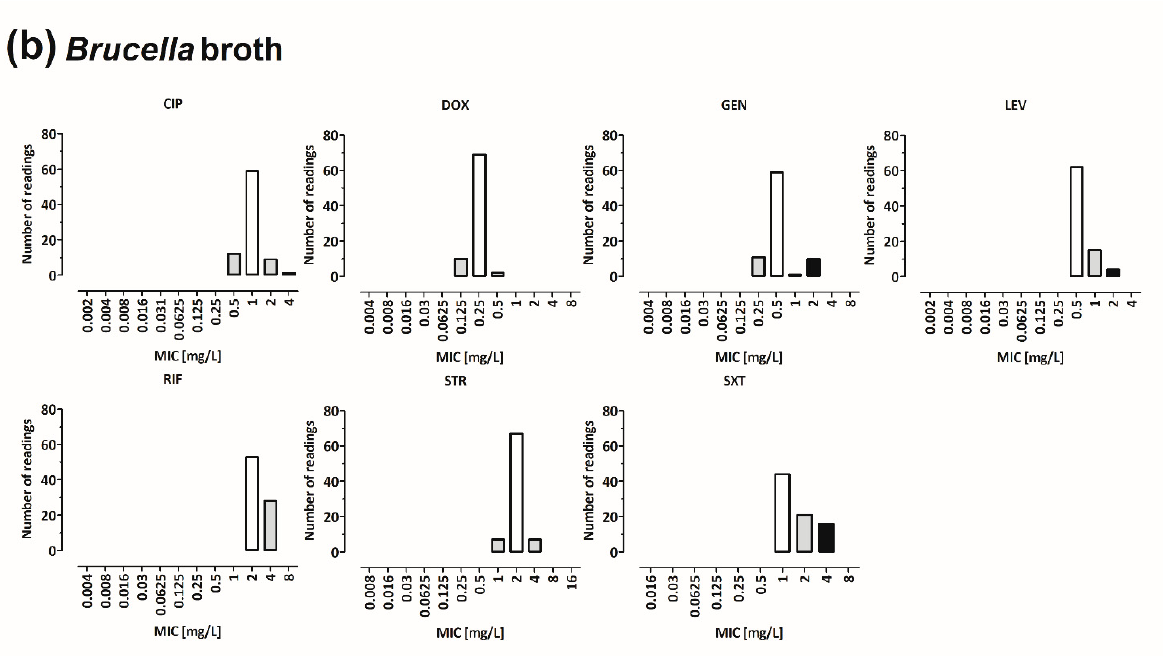
Figure 6. MIC values resulting from the interlaboratory validation (ILV) experiments where eight partner laboratories performed BMD with the B. melitensis clinical isolate Bm150048 using CAMHB ( a ). Four out of seven antimicrobials fulfilled the prerequisite to set a reference range: ciprofloxacin (0.5 mg/L ± 1 log 2 dilution step), gentamicin (0.25 mg/L ± 1 log 2 dilution step),